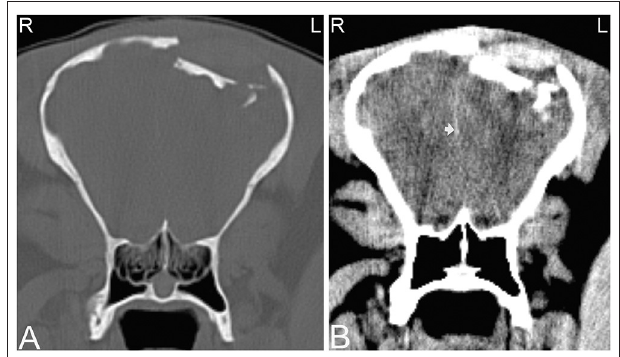
FIGURE 15 | Compression skull fracture with brain hemorrhage. Computed tomography images of the head of a Miniature horse with a history of running into a wall and falling backwards. Transverse CT images displayed in a bone window (A) demonstrate a large, comminuted depression fracture of the left parietal bone with ventral displacement of several bone fragments into the brain. CT images displayed in a soft tissue window (B) illustrate large areas of patchy hyperattenuation in the left brain, which causes a mild rightwards displacement of the falx cerebri (white arrow). Similar areas of hyperattenuation are also seen in the soft tissues dorsal to the compression fracture. These hyperattenuating areas are most consistent with acute intracranial brain hemorrhage, and hematoma formation as well as hemorrhage and/or hematoma formation within the adjacent soft tissues. L, left; R,